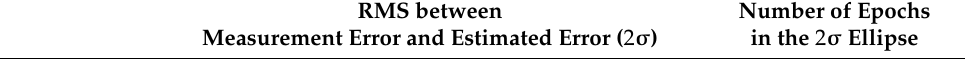
Table 3. Result of GNSS sensor model verification. RMS between Number of Epochs Measurement Error and Estimated Error ( 2 σ ) in the 2 σ Ellipse Proposed 0.42 m 97.6% Conventional 1.08 m 72.8%